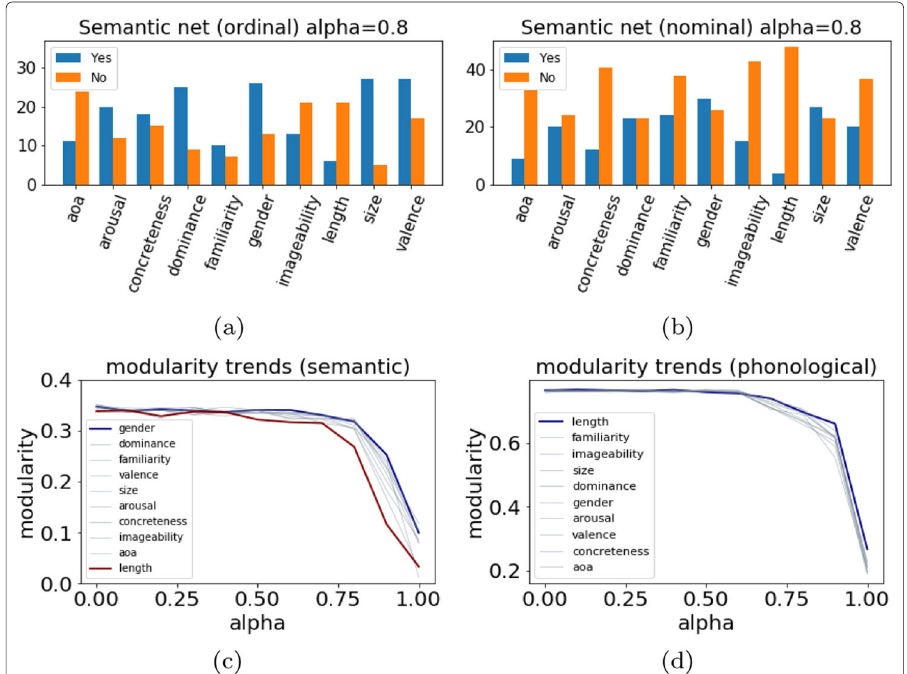
Fig. 3 In the first row, the two bars (respectively, Yes or No ) captures, for each attribute, if the second and the third most frequent labels within a community are at a distance d ± 1 from the most frequent label. The ordinal strategy is applied in a , and, in b , the nominal one: in a , ageofacquisition ( aoa ), imageability and length are the dimensions where an ordered label distribution is not achieved in the majority of communities, evidently because these properties do not constitute homophilic dimensions of a semantic network. In the second row, figures c - d , it is analyzed the modularity degradation w.r.t. the linguistic dimension: in c for the semantic network, in d in the phonological